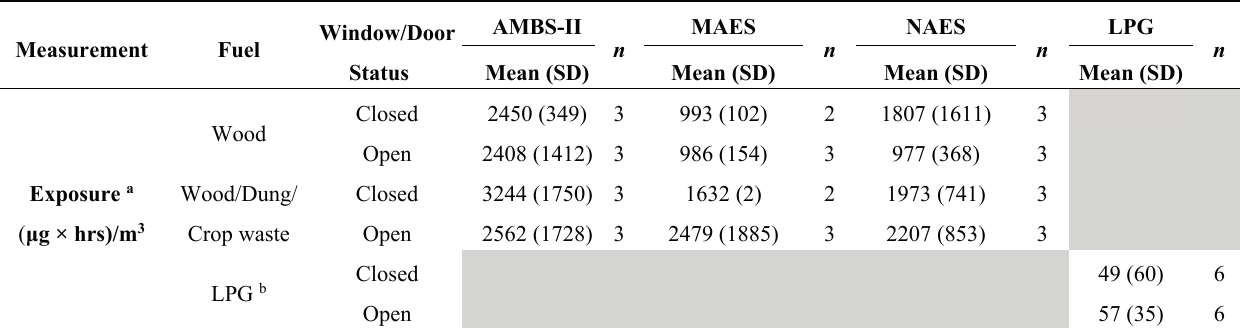
Table A4. Summary of exposure in Study II comparing three alternative cookstoves with an improved brick stove in a home setting in rural